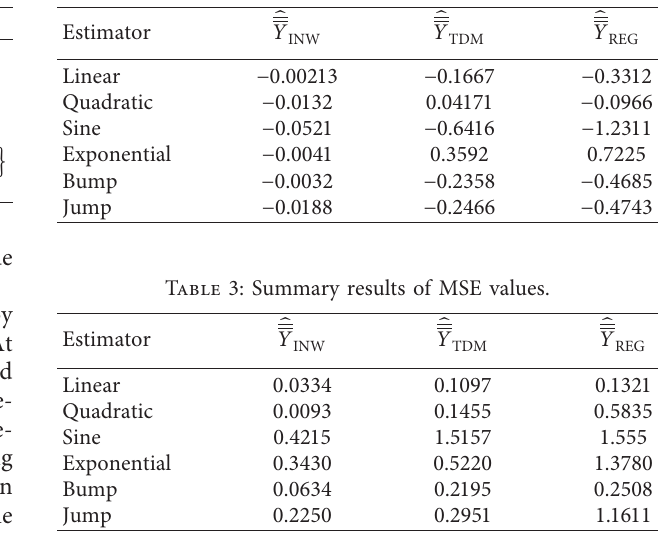
Table 2: Summary results of bias.